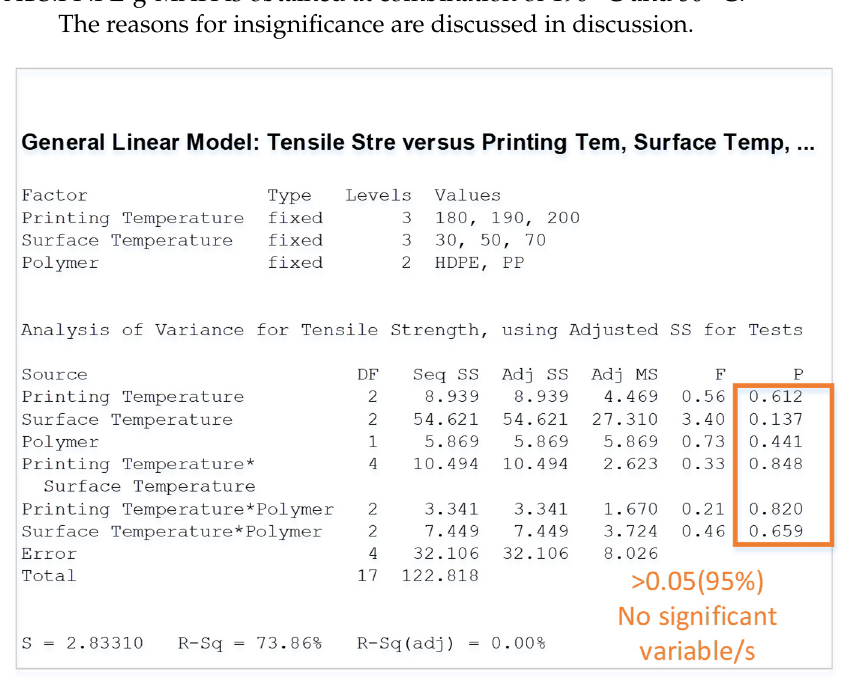
Figure 3. ANOVA analysis.